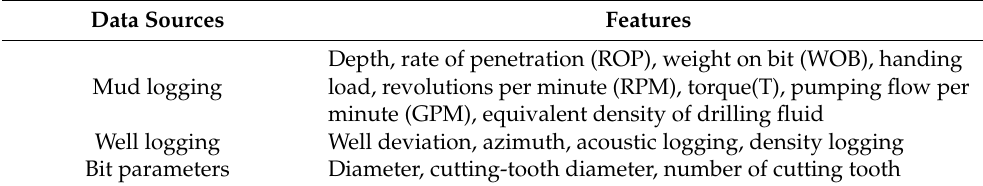
Table 2. Oilfield multi-source data.